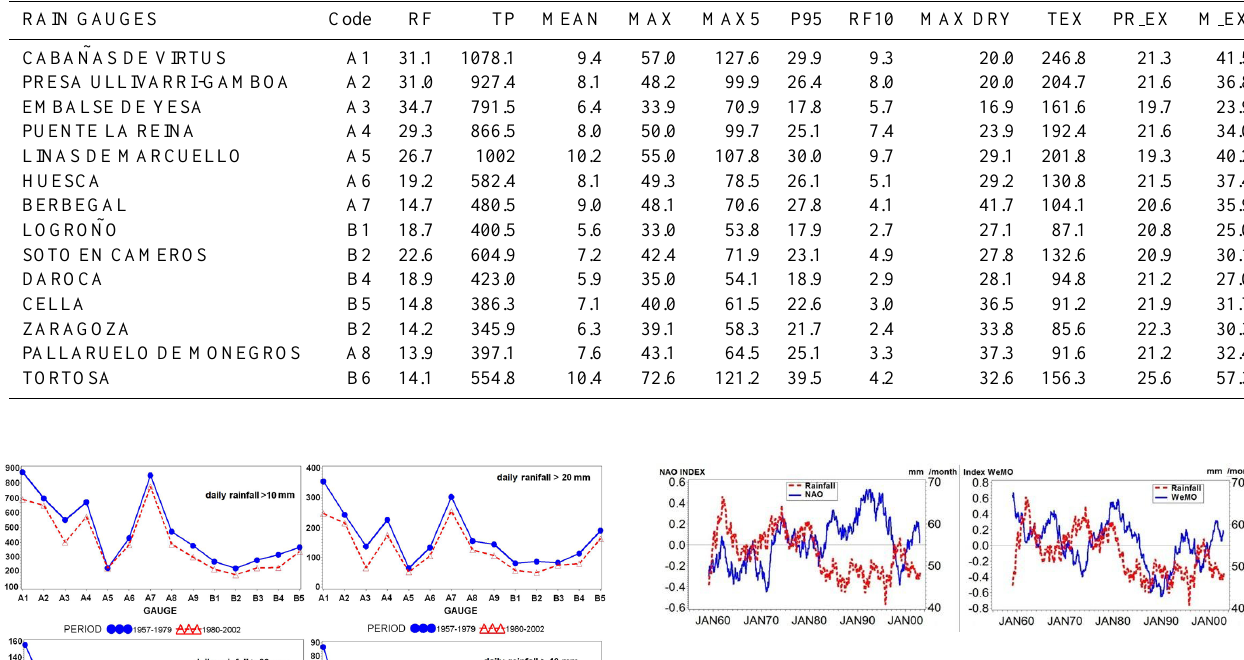
Table 1. Mean of the rainfall climatic indexes at the selected stations for 1957–2002 period. Relative frequency of rainy days (RF), total annual precipitation (TP), mean precipitation in a rain day (MEAN), daily maximum (MAX), maximum 5-day precipitation total (MAX5), percentile of order 0.95 based on wet days (P95), relative frequency of days with precipitation ≥ 10mm (RF10), maximum number of consecutive dry days (MAXDRY), annual accumulation of rainfall extremes (TEX), proportion of annual accumulation due to extreme events (PREX), mean of extreme events (M EX).